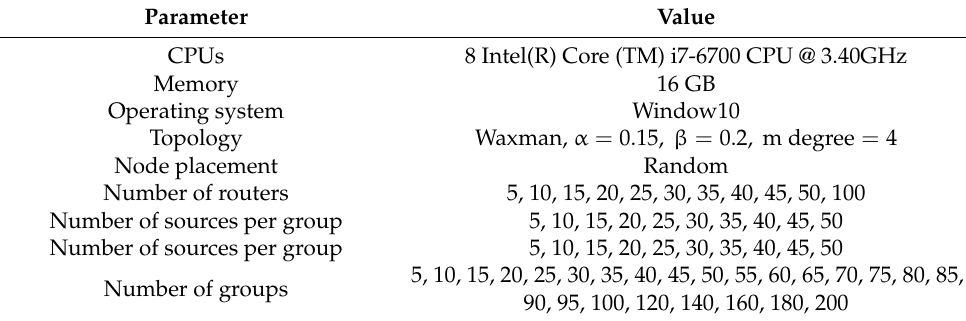
Table 3. Evaluation